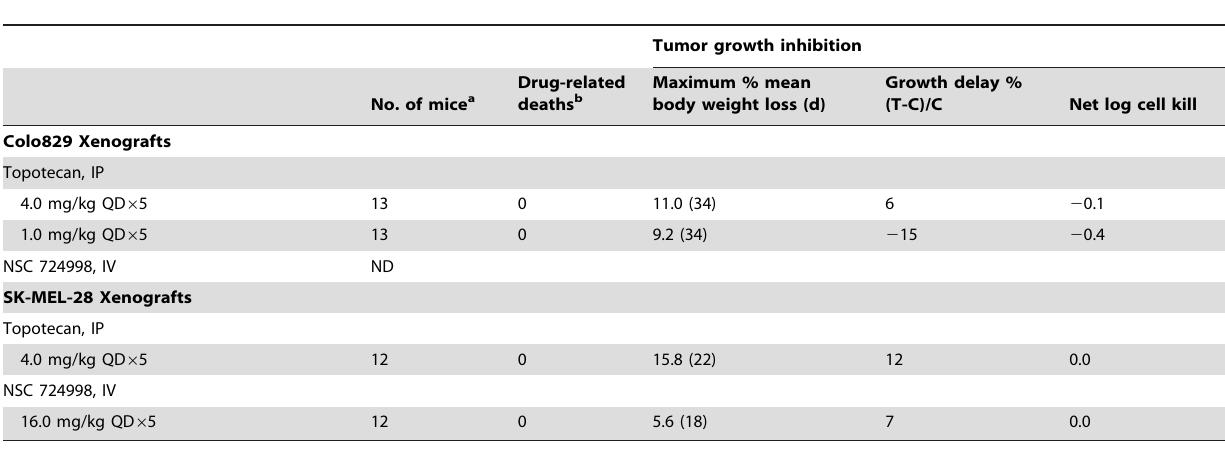
Table 4. Tumor response and biomarkers for Top1 inhibitors in topotecan-nonresponsive and moderately responsive xenograft